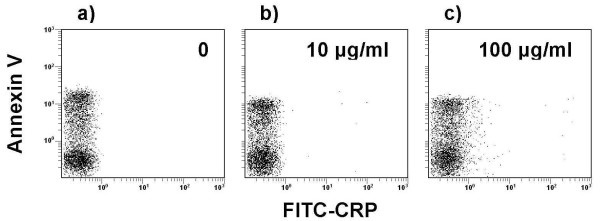
Lack of CRP binding to early apoptotic human neutrophils. FITC-CRP binding to aged human neutrophils was assessed by dual color flow cytometry using annexin V-PE to identify apoptotic cells. In comparison with buffer alone (a), FITC-CRP did not bind to apoptotic neutrophils at concentrations up to 100 μg/ml (b,c).